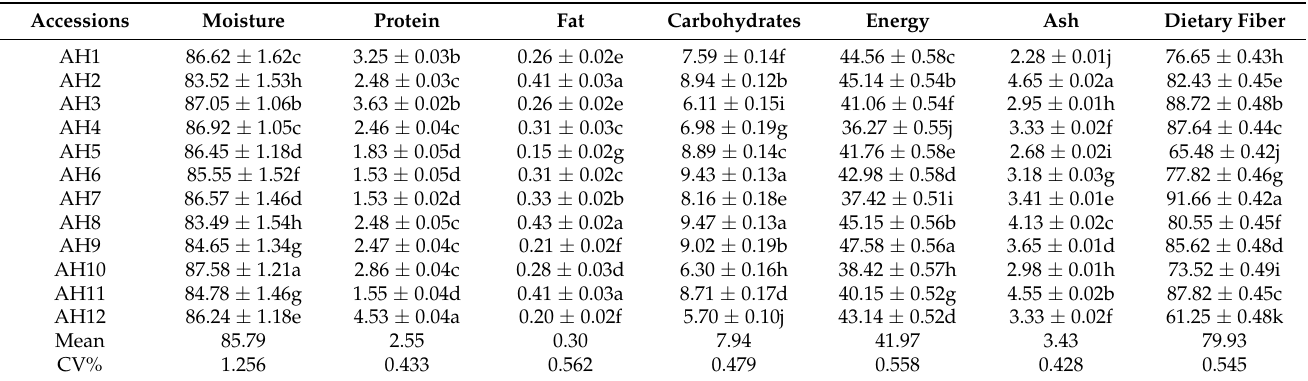
Table 1. Energy (kcal per 100 g fresh weight, FW), dietary fiber ( µ g g − 1 FW), and proximate (g per 100 g FW) of 12 slim amaranth